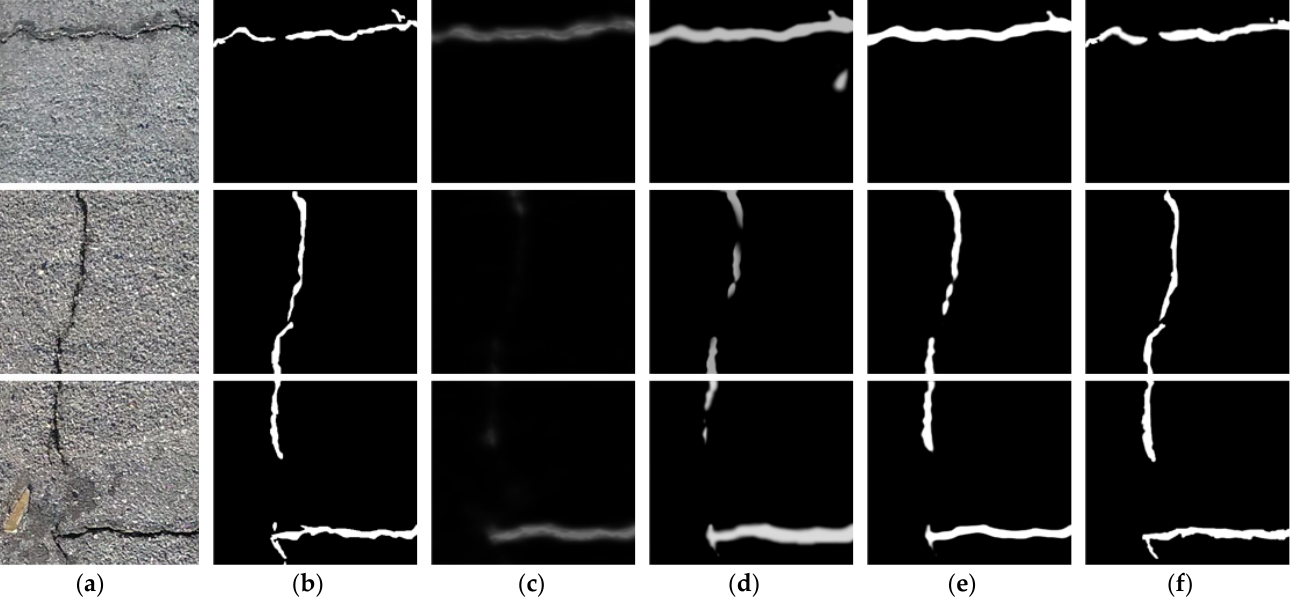
Figure 12. Subjective comparison results of the ablation experiments: ( a ) original image; ( b ) the ground truth; ( c ) the segmentation result using only a single ‐ loss module; ( d ) the segmentation results using only the multi ‐ loss module; ( e ) the segmentation result using only the morphological module; ( f ) the segmentation results with the combination of multi ‐ loss and morphological module.